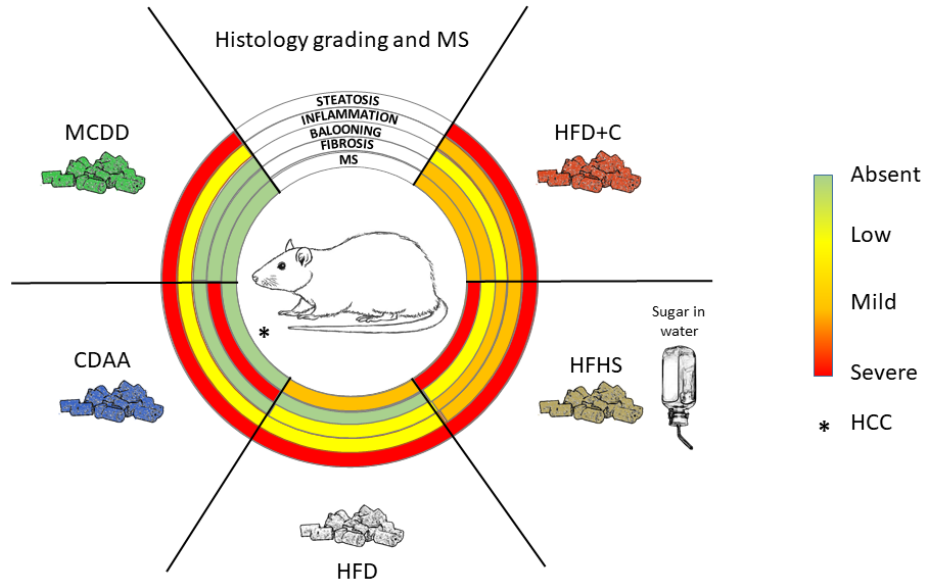
Figure 3. Key nonalcoholic fatty liver disease (NAFLD)/nonalcoholic steatohepatitis (NASH) histo-